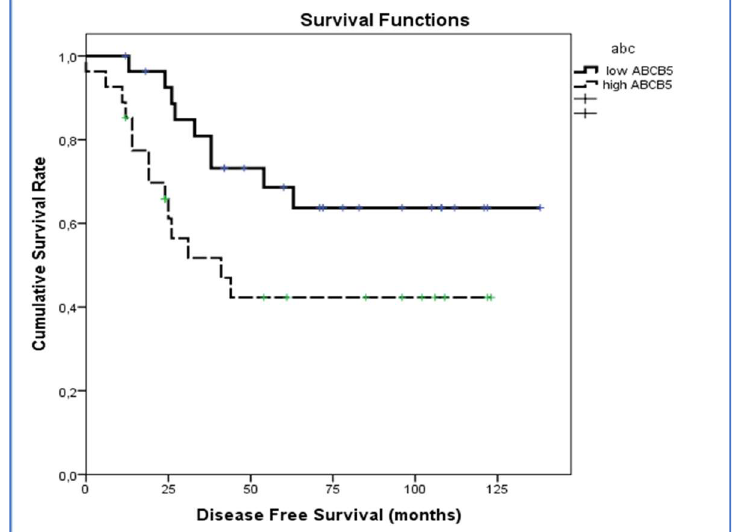
Figure 4. Kaplan–Meier survival analyses in patients with uveal melanomas with low and high ABCB5 expression. The log-rank test showed a significant difference ( p = 0.039) between the two groups in ABCB5 expression.